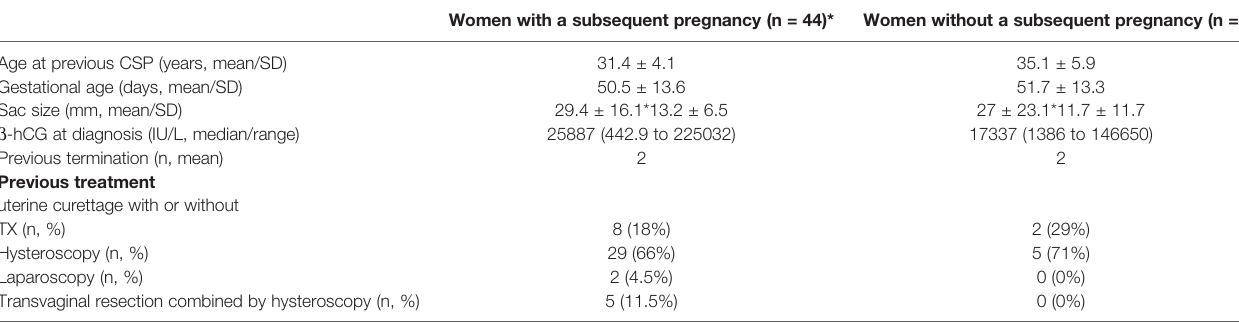
TABLE 1 | Clinical characteristics in women with a history of caesarean scar pregnancy who had or did not have a subsequent pregnancy. Women with a subsequent pregnancy (n = 44)* Women without a subsequent pregnancy (n = 7) Age at previous CSP (years,